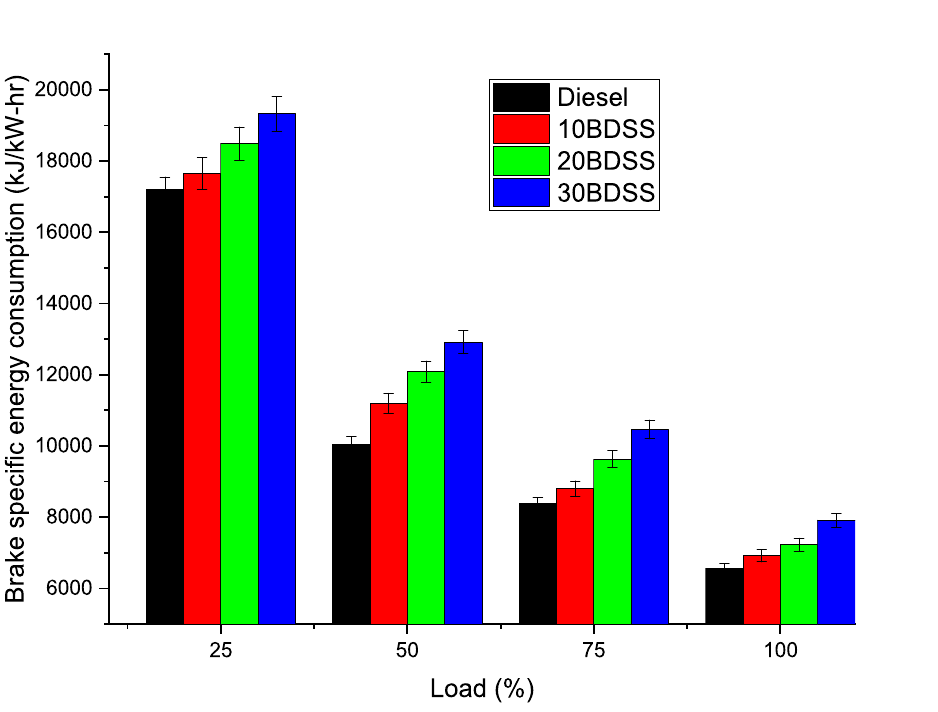
Figure 6. Influence of biodiesel blends in BSEC (Brake specific energy